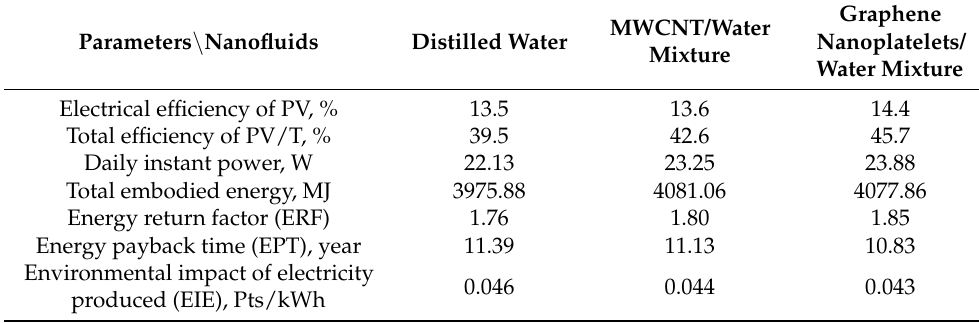
Table 4. General results of the thermal, LCA, and CED analyses for the experimental setup.